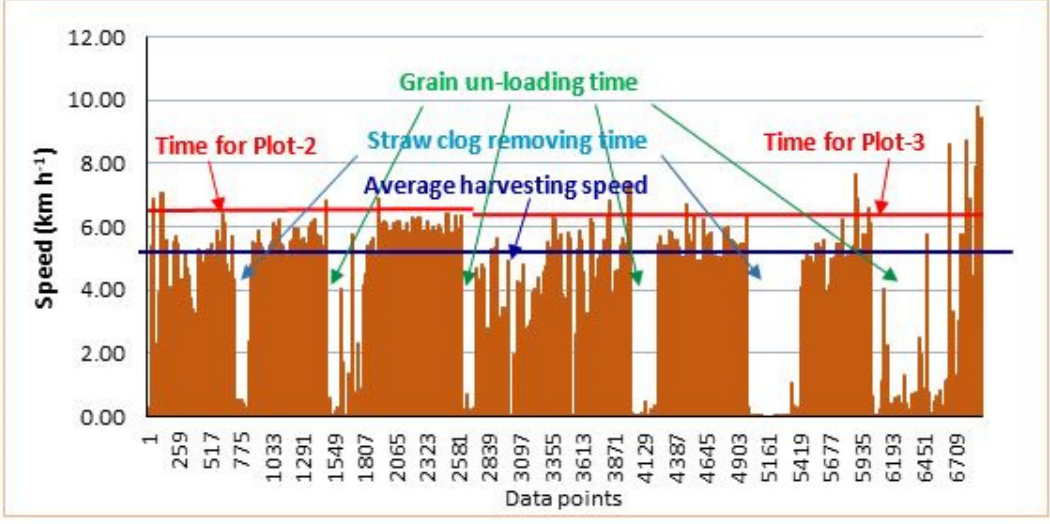
Figure 7. Different speeds and idle times during harvesting at Plots 2 and 3 by large combine. The total machine operation times, idle times, and effective harvesting times are presented in Table 3. Idle times represent not only the still position (speed was 0 km h − 1 ) but also the times for moving to the unloading point and returning to the previous harvesting point (speed was highest). During the harvesting operation, the total number of idle ac- tivities was eight for the medium combine (grain unloading six times and straw clog re- moving two times) and six for the large combine (grain unloading four times and straw clog removing two times). The estimated time loss percentages due to idle time were 23.14% and 41.46% for medium and large combine harvesters, respectively. Time loss per- centages depend on the distances between the harvesting point and the grain storehouse. Additionally, they depend on crop conditions and operator skill. Harvesting field capacity and efficiency can be increased by reducing harvesting time losses. The pick-up operators should be aware of minimizing the grain shifting time from the field to the storehouse, and harvester operators must be skilled enough to operate the harvester properly and quickly implement troubleshooting in the field during harvesting time.